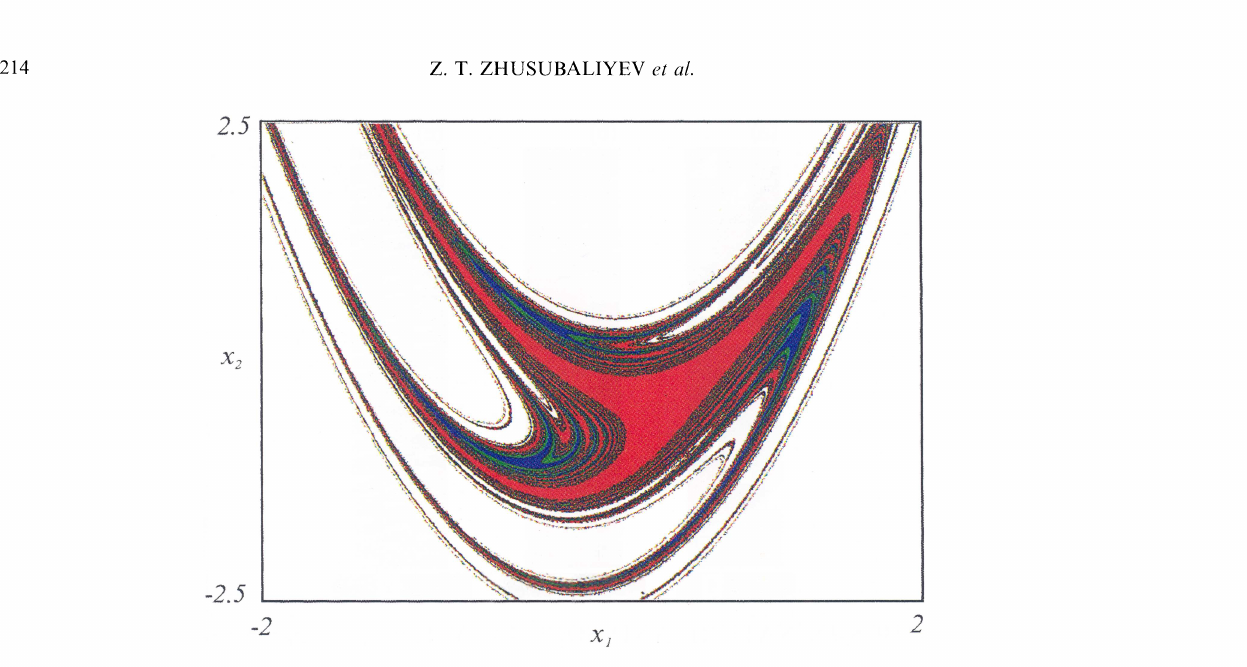
FIGURE 10 Basins of attraction for the 1-cycle, the 18-cycle, and the 3-cycle with (-- 1.0295,/3= -0.8. (See Color Plate III.)